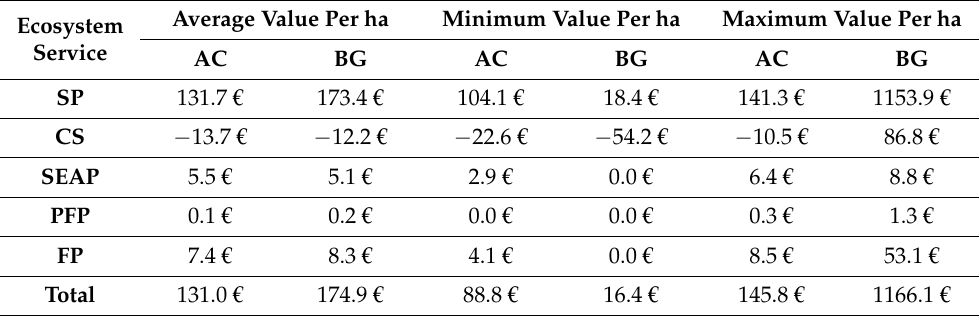
Table 3. Ecosystem services valuation in € /ha for the PBBF of the